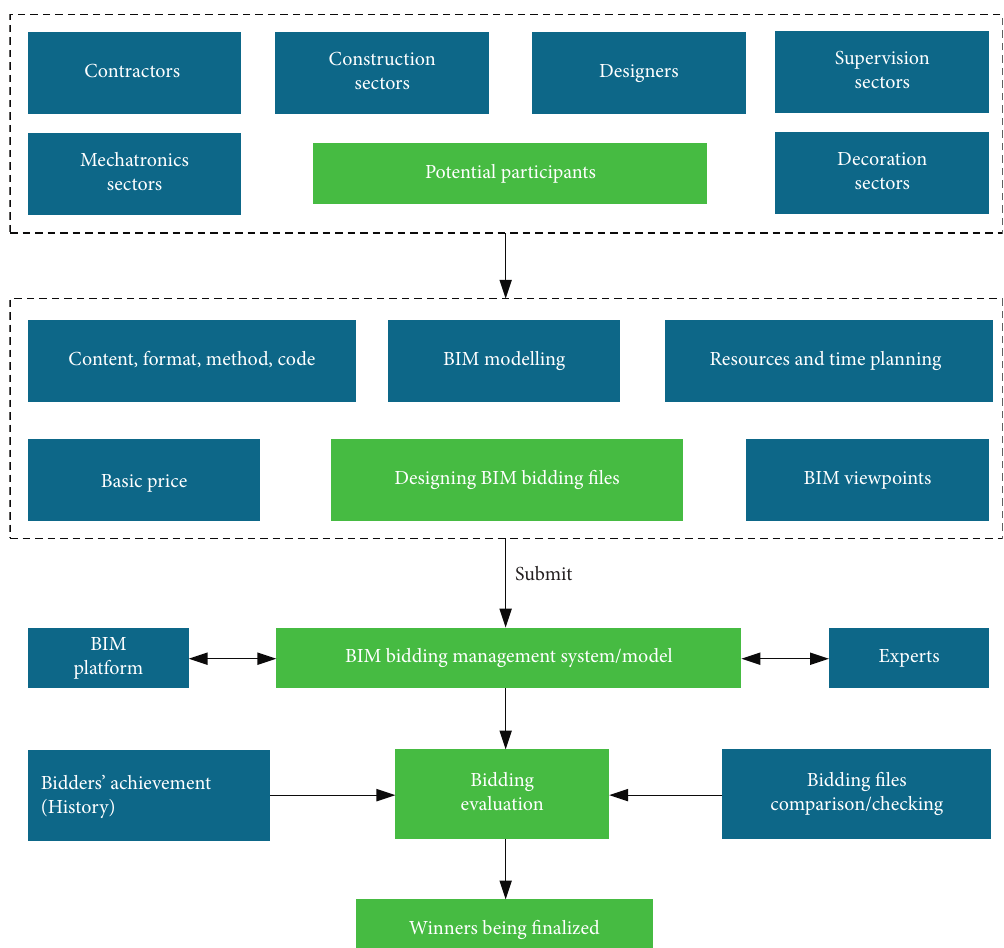
Figure 5: Flow chart of bidding management